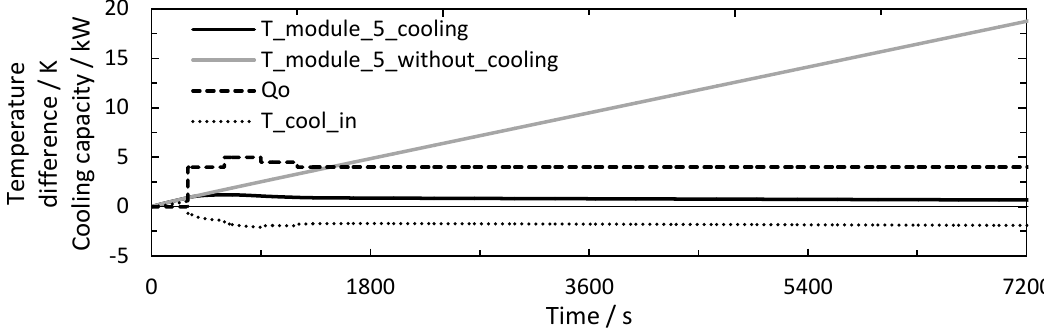
Figure 12. Coolant temperature, coolant capacity, and controlled and uncontrolled mean battery cell temperature of module 5 for a charging rate of 0.5 C. The temperature difference refers to the initial conditions.